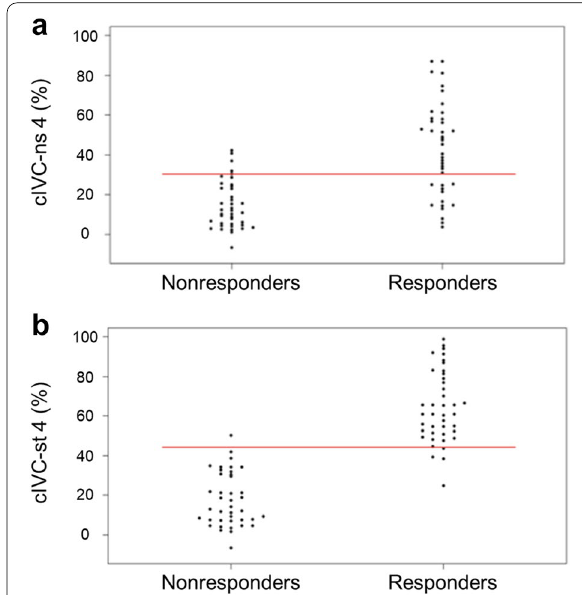
Fig. 3 Scatterplot of individual values for the collapsibility index of the inferior vena cava (cIVC). Scatterplot of individual values before volume expansion (VE) for cIVC measured at 4 cm caudal to the IVC– atrial junction in spontaneous breathing patients, both without ( a , cIVC-ns 4) and with ( b , cIVC-st 4) standardized breathing manoeuvre, in non-responders and responders to VE. Red lines show the